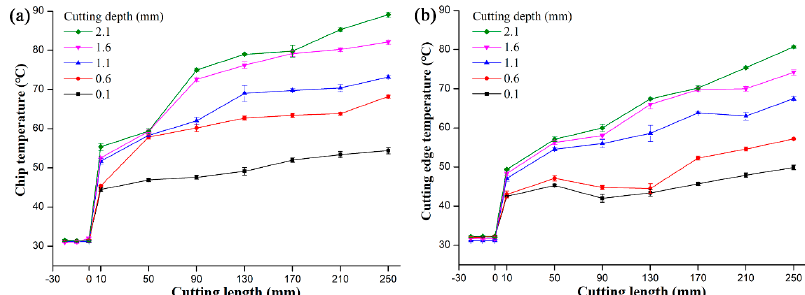
Figure 7. The maximum cutting temperature at varying cutting depths for the ( a ) cutting edge and ( b ) chips. Each point is the average of five measurements, and the error bars of each data point represent one standard deviation.